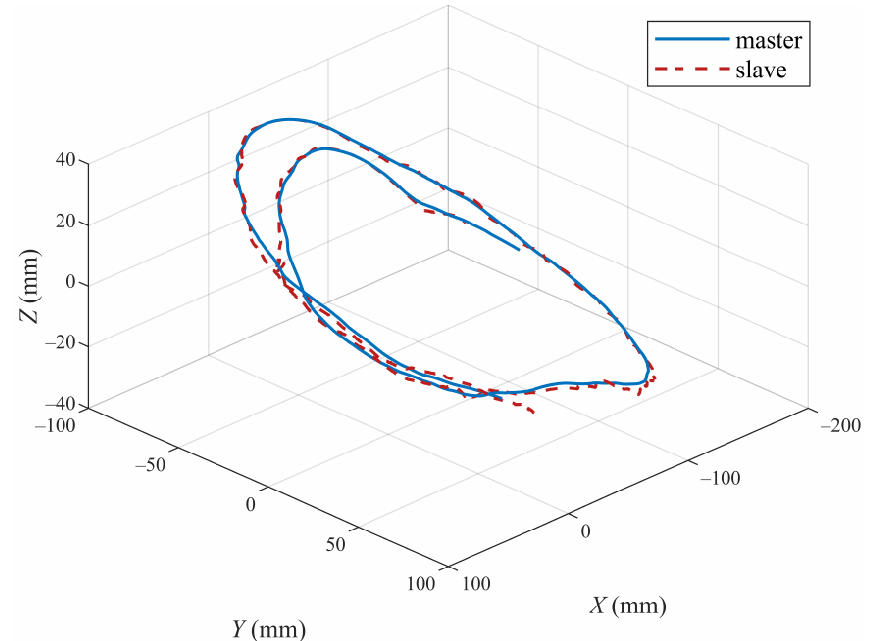
Figure 12. Tracking control performance of end-effectors of master and slave robots based on the proposed algorithm.